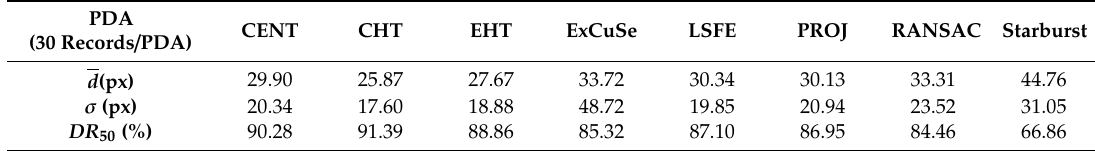
Table 2. Mean value and standard deviation of the Euclidean distance and DR 50 for all tested PDAs in the scene image.